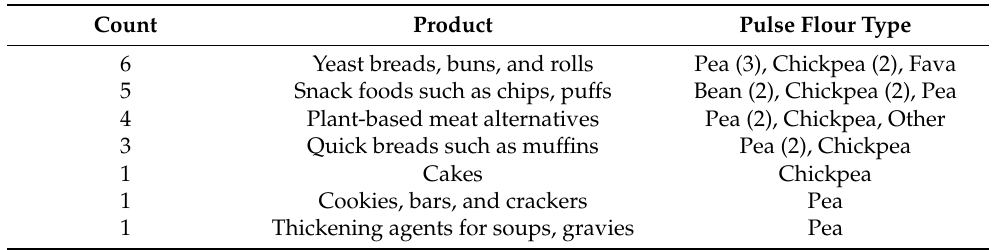
Table 6. The combinations of product and pulse flour that the 21 current, previous, or considered (CPC) users selected. Counts more than one are shown in parentheses.